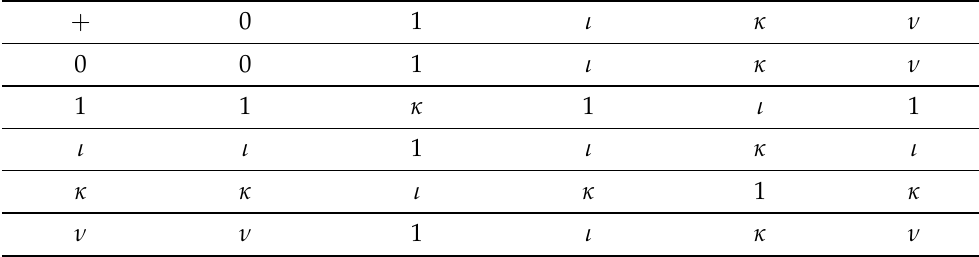
Table 2. Table of binary addition. ( S = { 0,1, ι , κ , ν }